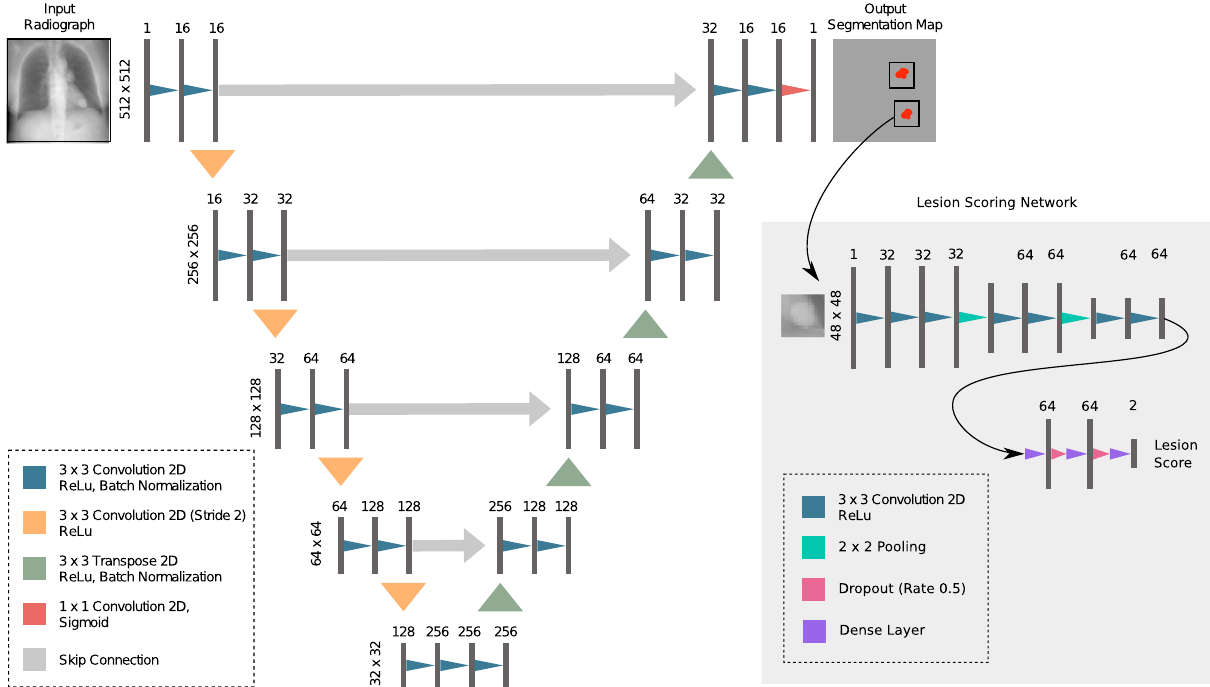
Figure 7. Architecture of the utilized U-Net. Input and output were a single channel 512 × 512 matrix. Downsampling was performed using convolutional layers with a stride of 2. A second network (lesion scoring network) was used to retrieve a per-lesion score of the segmented nodules. Numbers above layers indicate convolution filters for convolution layers and number of neurons for dense